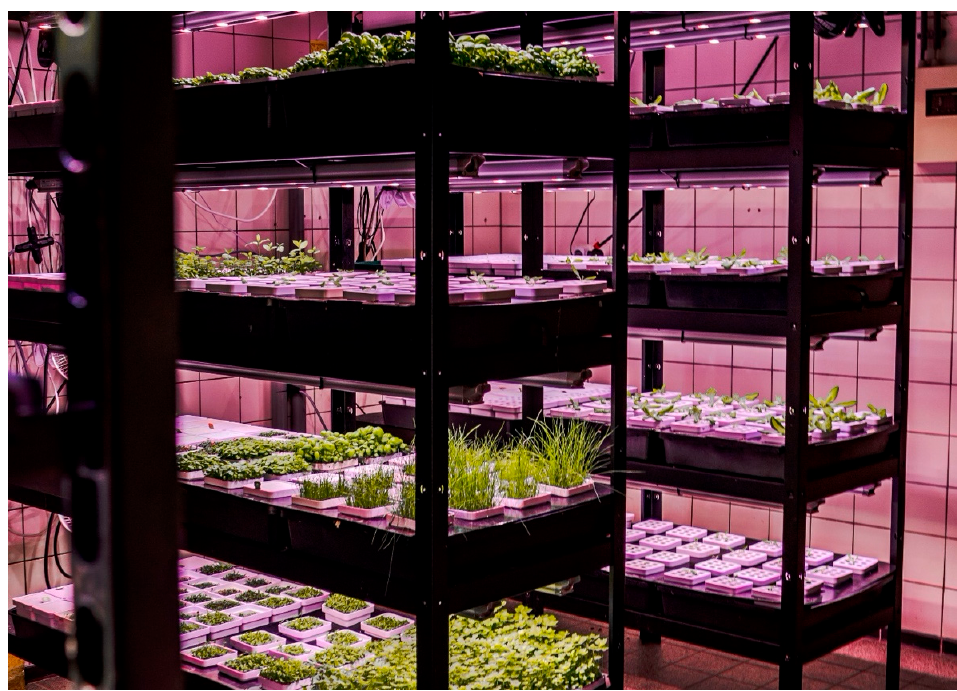
Figure 7. Hydroponic systems of a science-based company in Rafsanjan.